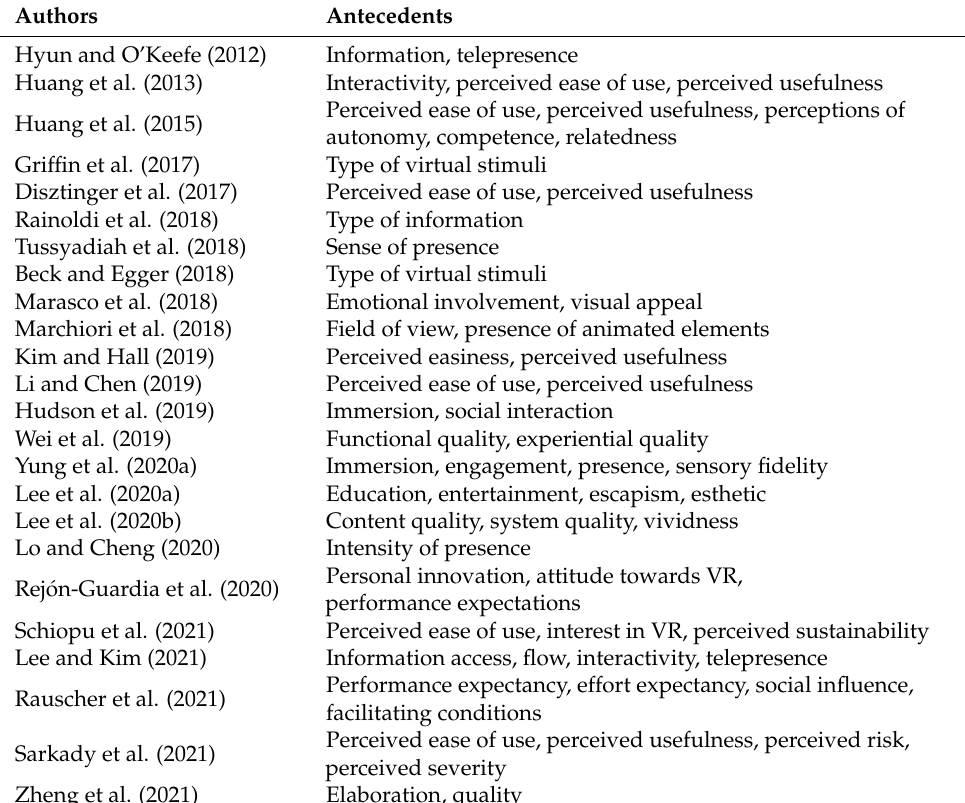
Table 1. Antecedents of virtual